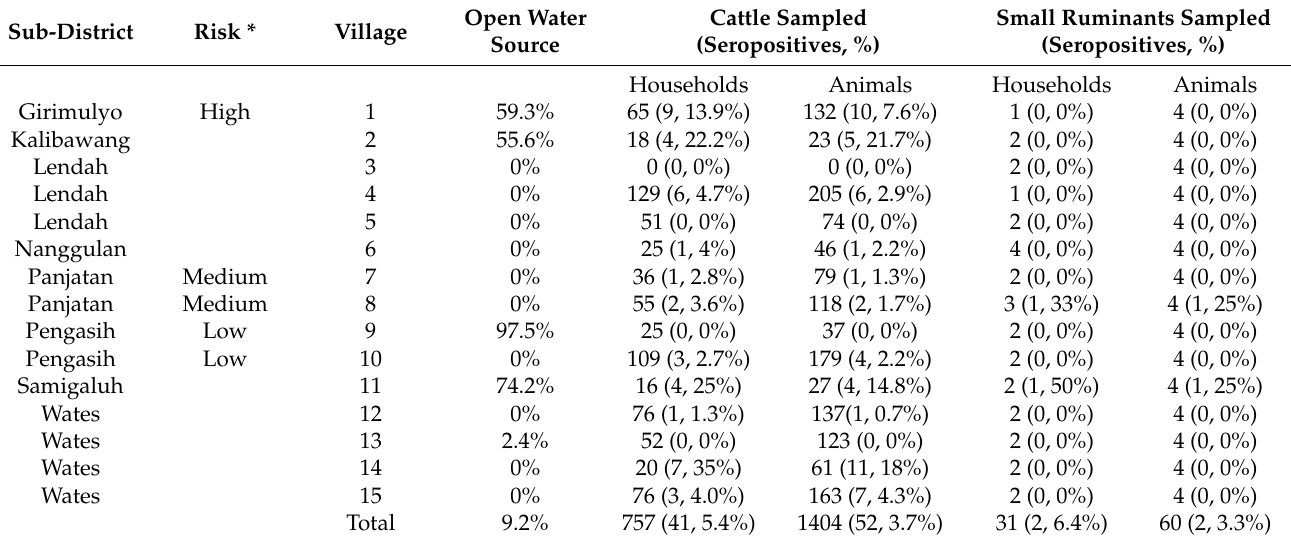
12 cattle being sampled per household. In addition, four small ruminants were sampled per village. Following this, 1464 ruminants (1404 cattle and 60 small ruminants) were sampled from 775 villages (Table 1). Table 1. Number of sampled households and animals, as well as the proportion using open water sources, and the seropositivity for leptospirosis at household and animal level in Yogyakarta Special Province, Indonesia.